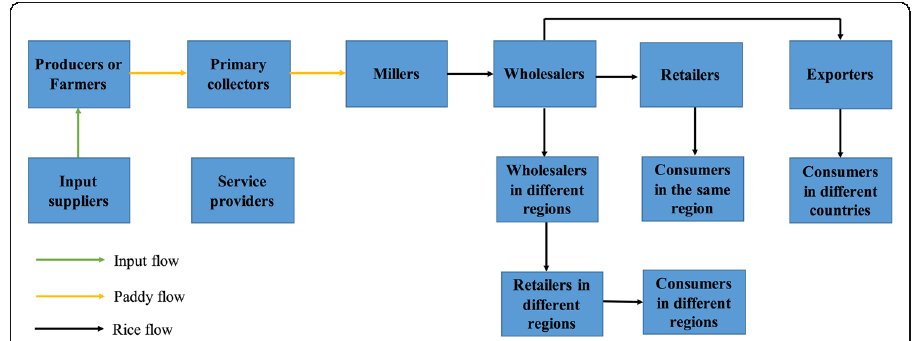
Fig. 1 Structure of the rice value chain in the study area. Source: own survey